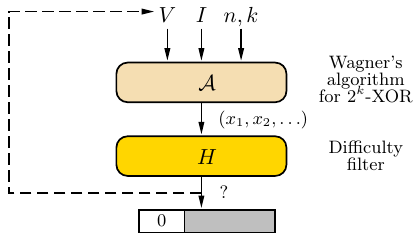
Fig. 2. Equihash: proof-of-work based on the generalized birthday problem